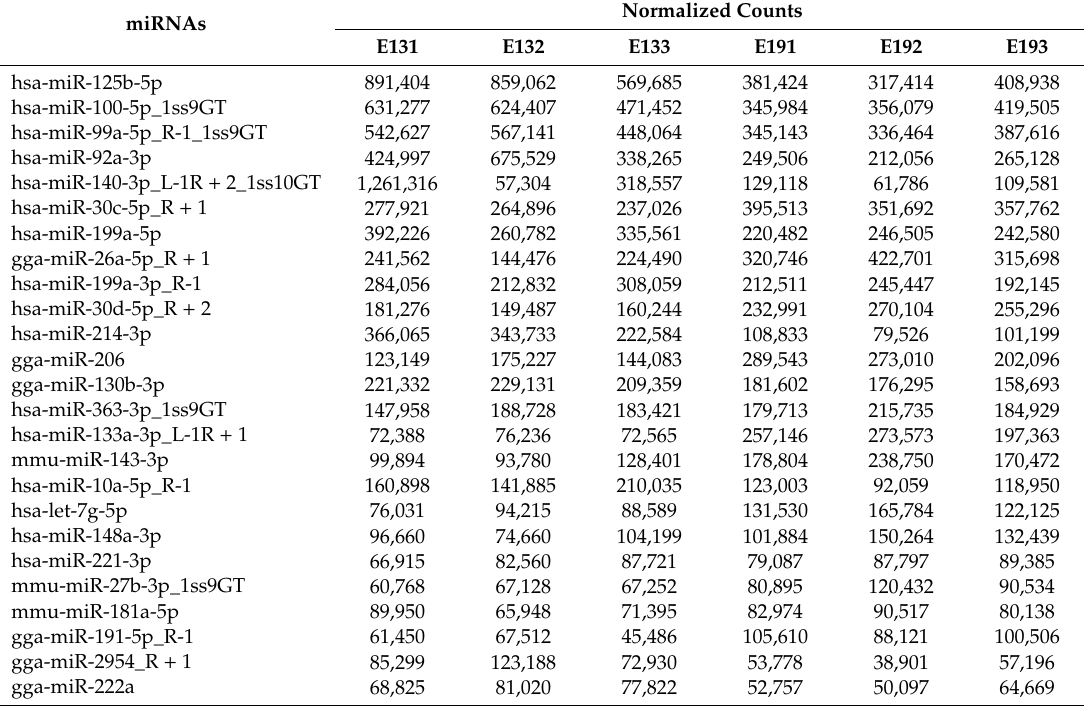
Table 2. Top 25 most abundant miRNAs in breast muscles of embryonic Shan Ma